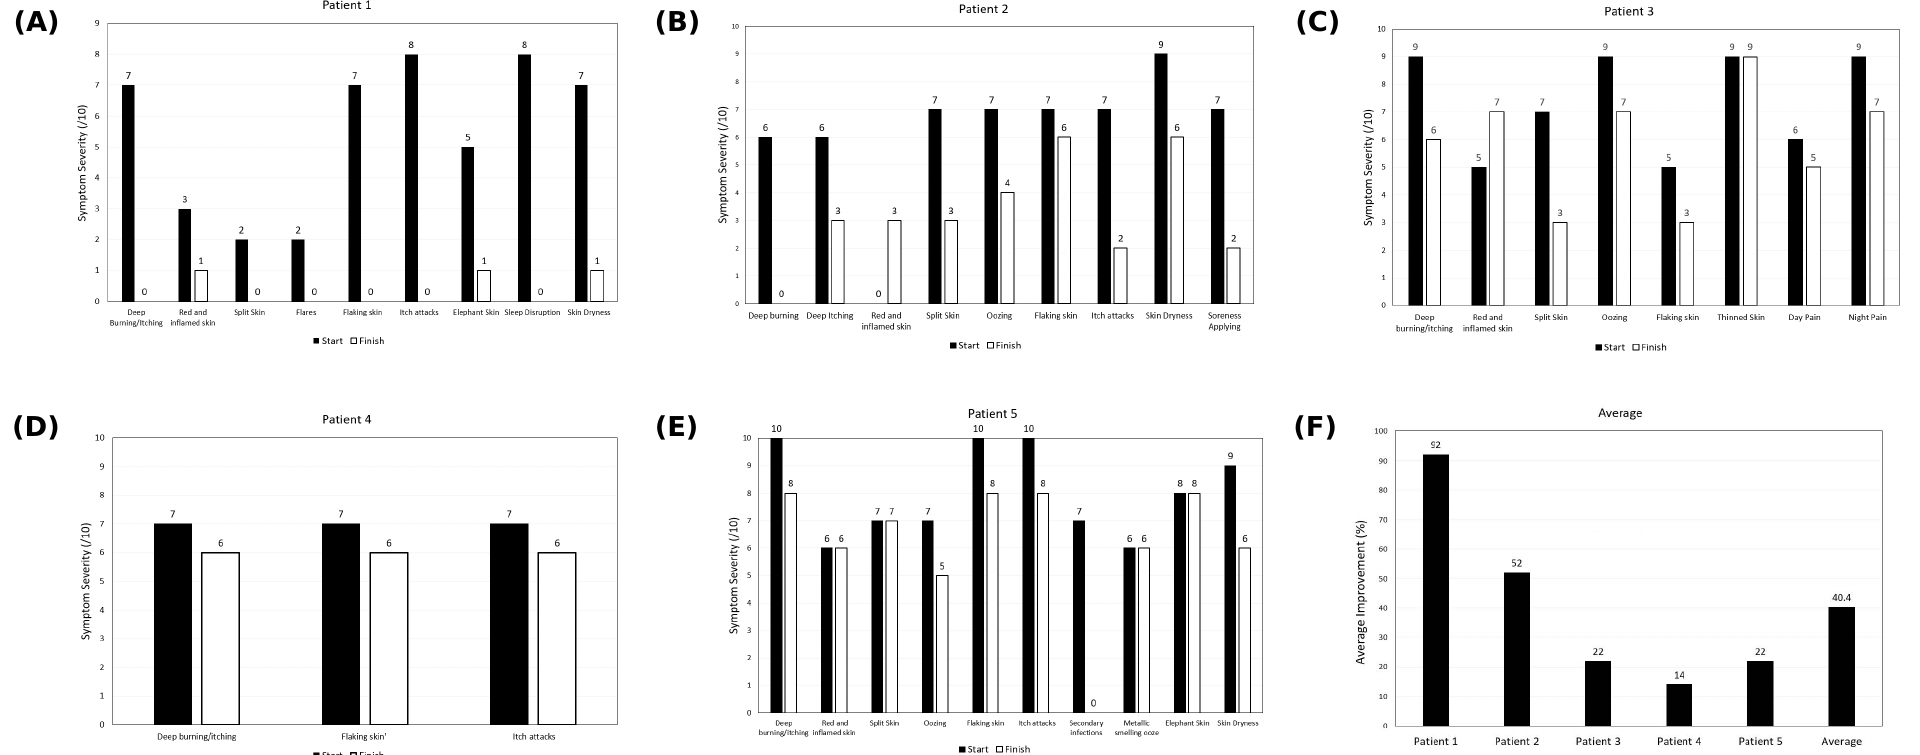
Figure 2. Change in severity of symptoms seen by the participants. The bars in black show the severity of each symptom at the start of the study, and the bars in white show the severity at the end of the study. Severity was measured in a self-assessed value out of ten, where ten was the worst possible. Graph ( A ) is Patient 1, Graph ( B ) shows Patient 2, Graph ( C ) shows Patient 3, Graph ( D ) shows Patient 4, Graph ( E ) shows Patient 5, and Graph ( F ) shows the average percentage change in symptom severity for each participant. A positive percentage indicates an improvement, and a negative percentage change indicates a worsening of